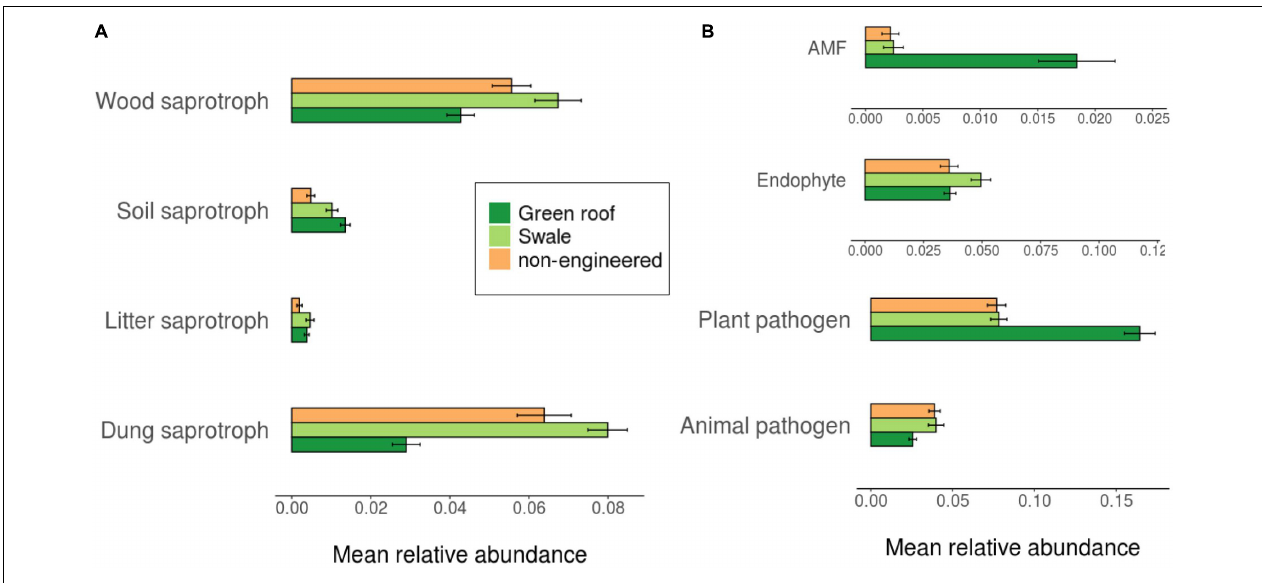
FIGURE 8 | Average relative abundance of trait-associated fungal